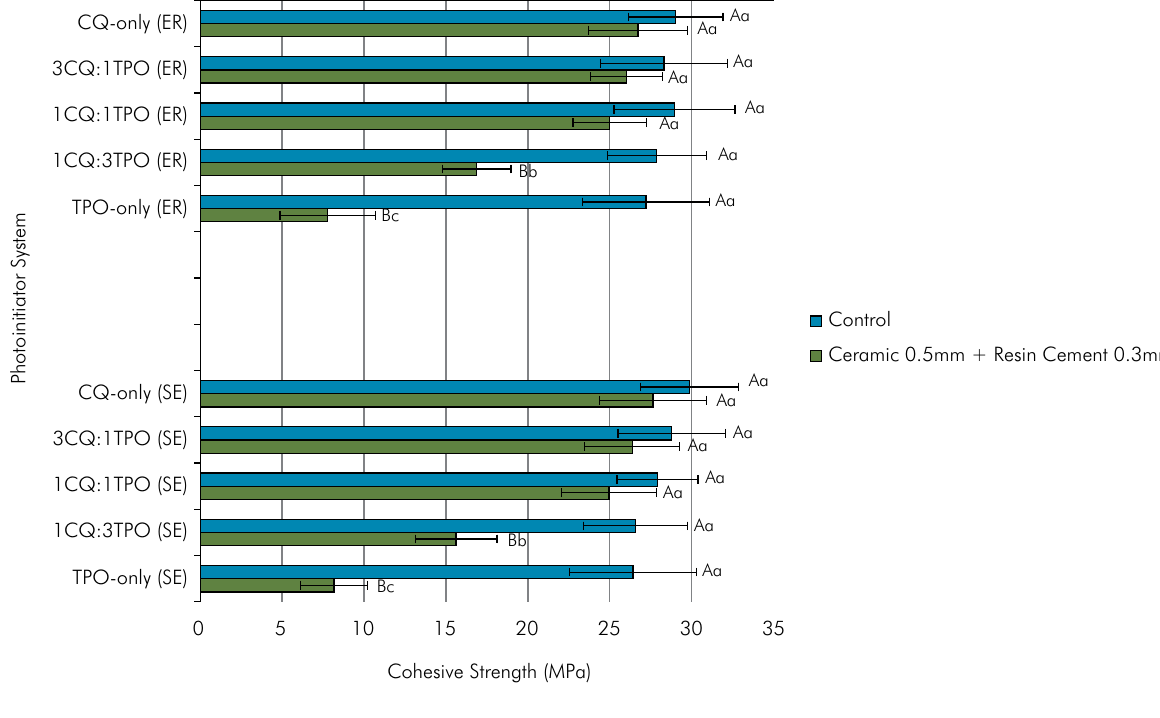
Figure 4. Cohesive strength for the tested experimental adhesives with different photoinitiator systems, photoactivated